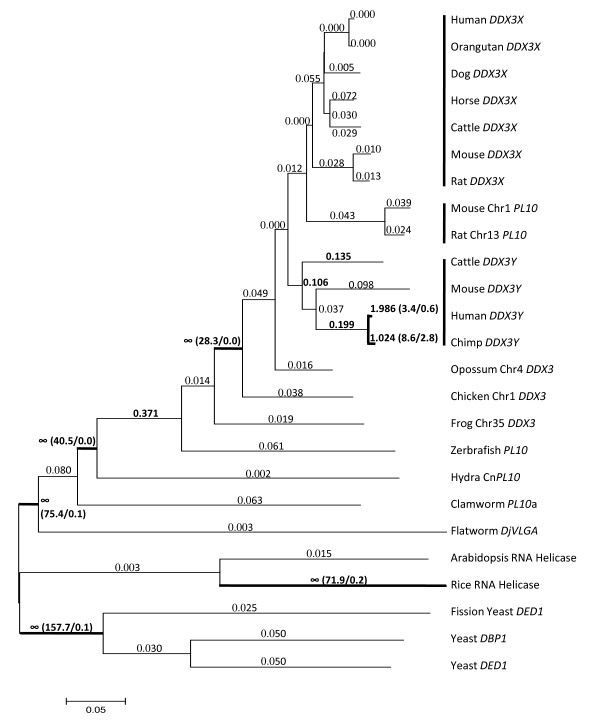
The tree of the DDX3 family established for the positive selection test based on Maximum Likelihood approach. The branch length was estimated in the unit of the number of nucleotide substitutions per nucleotide. Values larger than 0.1 are denoted in bold. The numbers in the parenthesis represent the estimated numbers of nonsynonymous substitutions against synonymous substitutions of the specific branch. Scale bar = 0.05 unit.